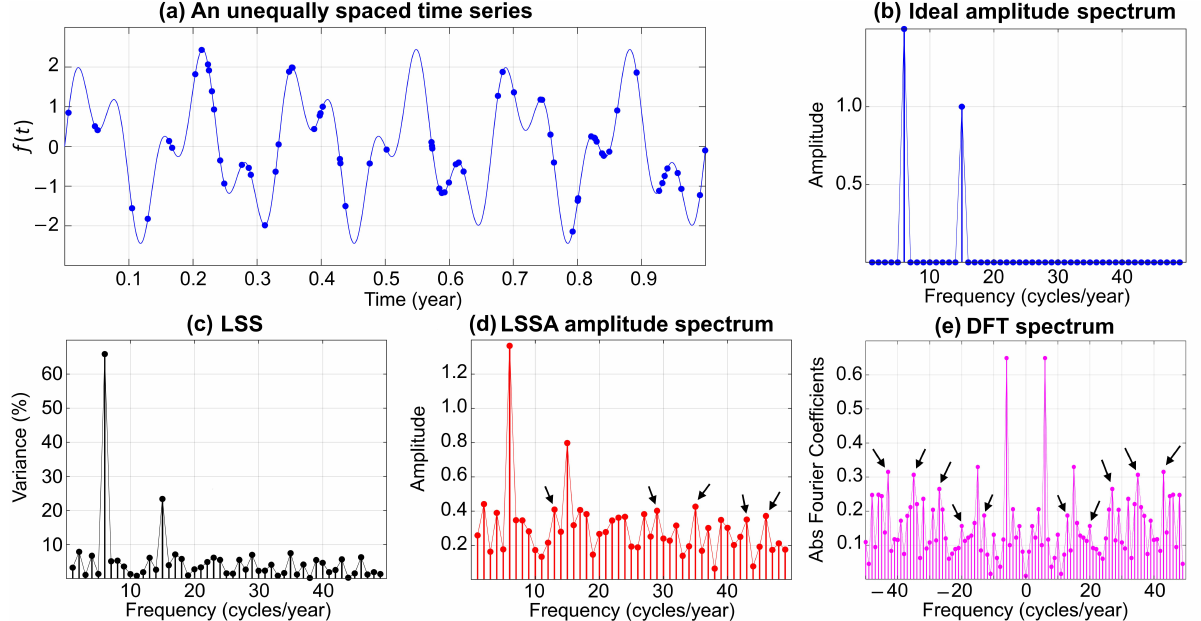
Figure 1. Spectral leakages in DFT and LSSA for unequally spaced time series. Arrows show many of the